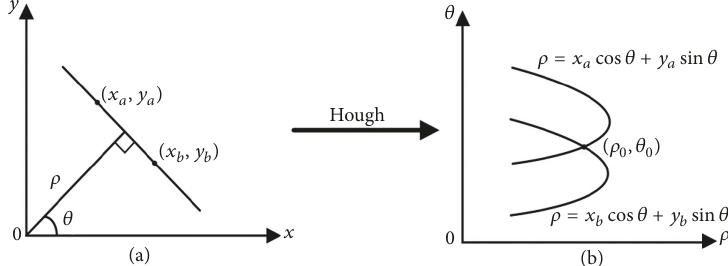
Figure 3: Hough transform. (a) Cartesian coordinate system parameter and (b) polar coordinate system